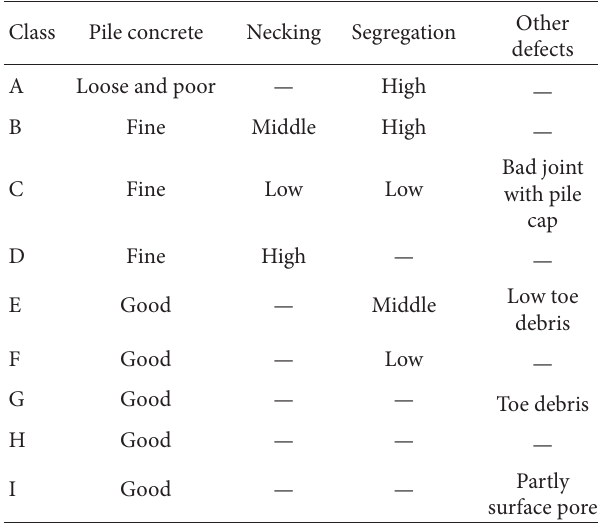
Table 1: Classification of the pile